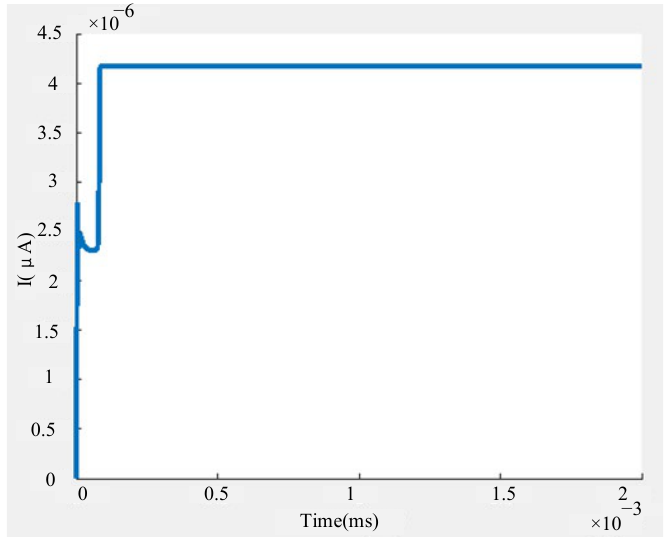
Figure 6. The total current of the proposed BGR circuit.